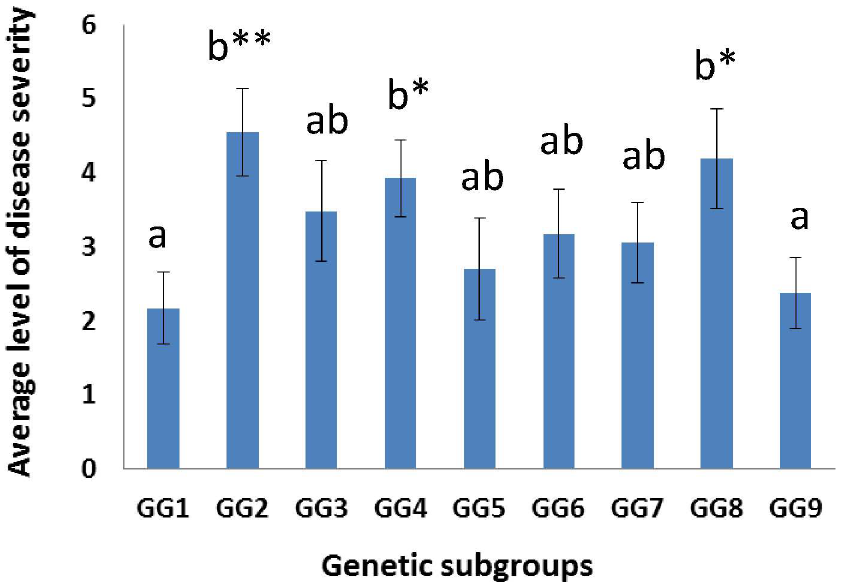
Fig 8. Association of whitebark pine genetic subgroups with relative levels of disease severity post inoculation by Cronartium ribicola . (a) Mean values of relativelevels of diseaseseverity were shown for seedlings with nine genetic subgroups (GG1 to GG9). Standard error (SE) was calculatedbasedon the entire subpopulation of each genetic subgroup. Statistical difference is significant(T-test and One-way ANOVA test, * P < 0.05, ** P < 0.01) betweensubgroupslabelledwith different